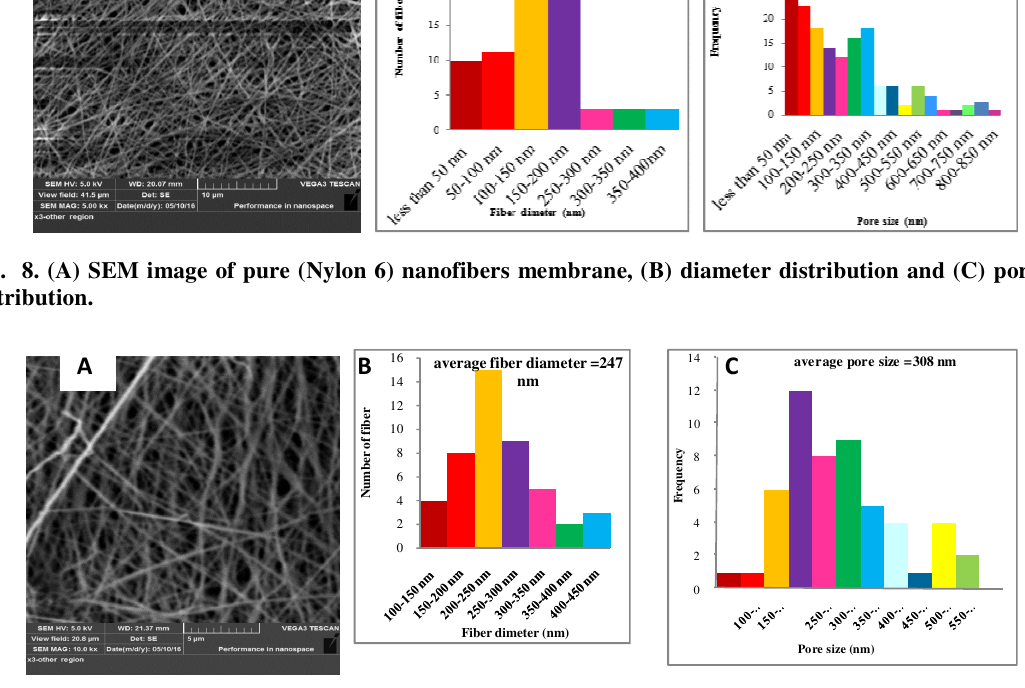
/Nylon 6) nanofibers membrane, (B) diameter distribution and 3